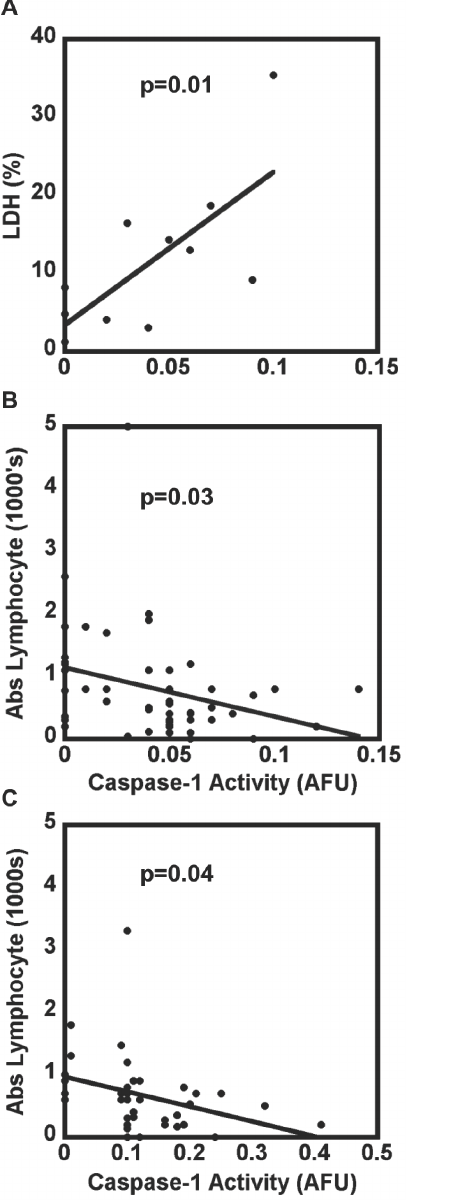
Figure 3. Caspase-1 activity and lymphocyte apoptosis. Caspase-1 activity measured from patient MVs correlated with the ability to induce ex-vivo lymphocyte cell death shown in Figure 2 ( A ). Microvesicles isolated from all 50 patients showed a correlation between degree of lymphopenia and microvesicular caspase-1 activity on day 1 ( B ) and day 3 ( C ).